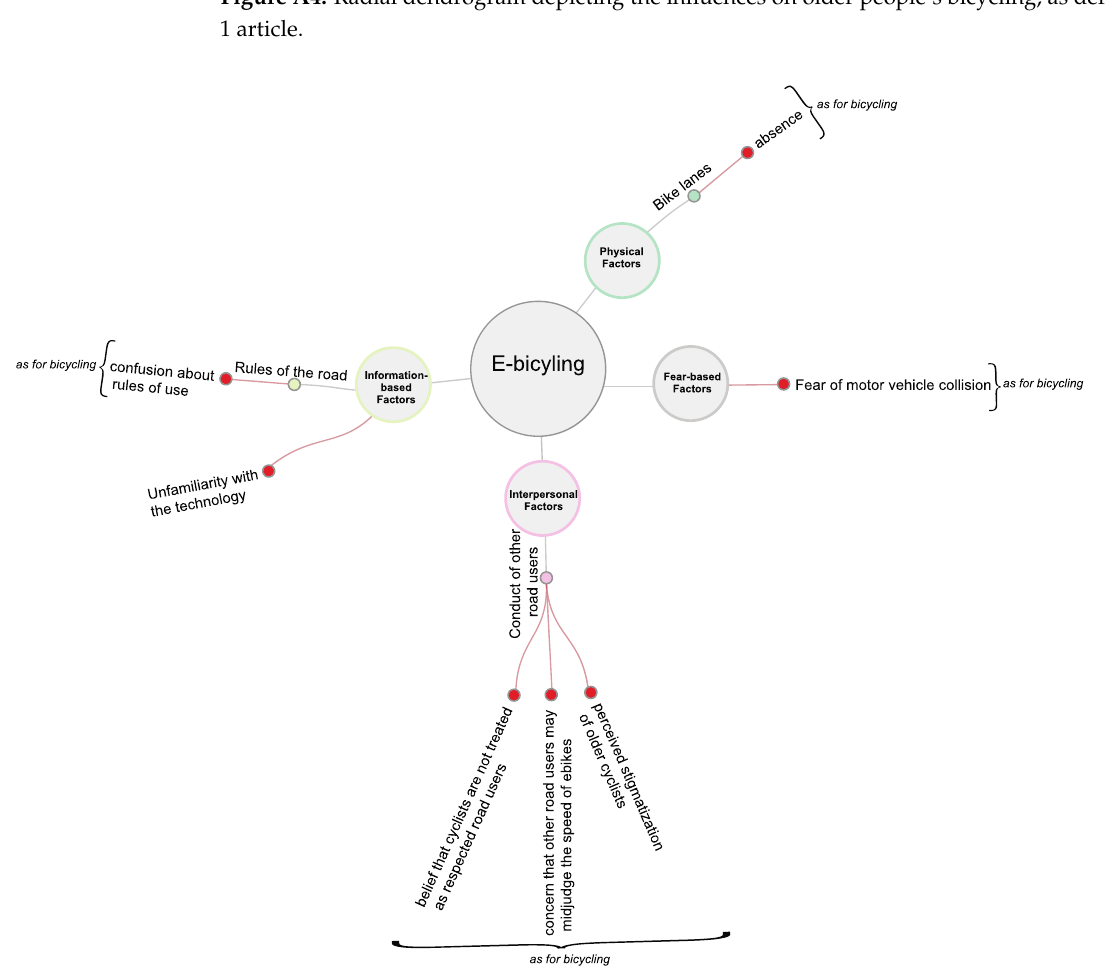
Figure A5. Radial dendrogram depicting the influences on older people’s e ‐ bicycling, as derived from 1 article.